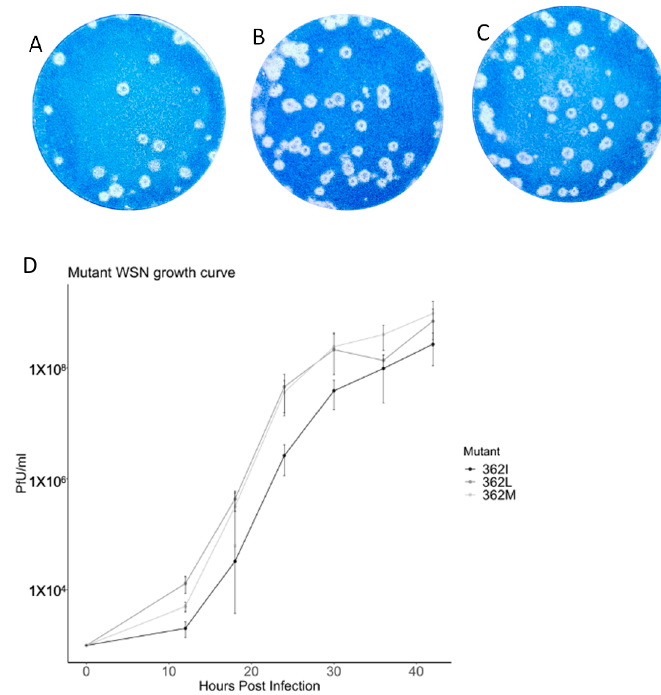
Figure 3. Plaque morphology and growth curves of different WSN mutant viruses. Viruses recon- stituted with different PB1 362 residues at P3 were infected to monolayer of MDCK cells and plaque assay was performed. All of the residues ( A ) 362M, ( B ) 362I and ( C ) 362L with polymerase activity generated infectious virions upon the 3rd passages. Remaining hydrophobic mutants, 362V and 362A, showed no plaque formed upon the 5th passage, suggesting the lack of ability to generate infectious virions. ( D ) Growth kinetics of WSN variants. 362M showed a lower growth rate within the first 12 h post-infection, while similar growth kinetics was observed compared with 362L after 18 h. 362I has the growth rate consistently lower than the two